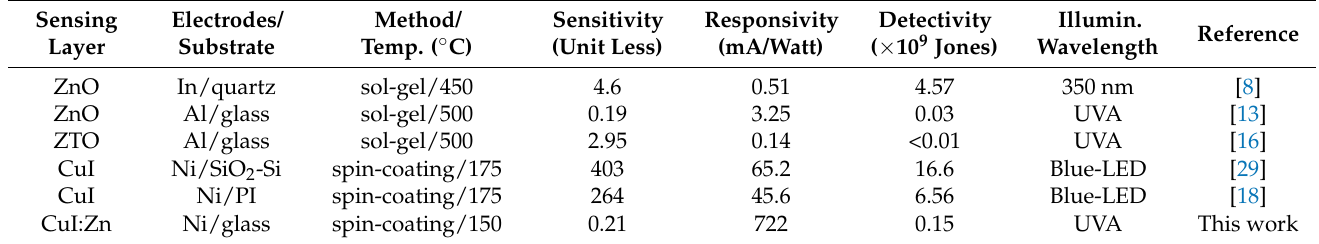
Table 3. Comparison of optoelectronic performance of different solution-processed MSM UV pho- todetectors based on wide bandgap